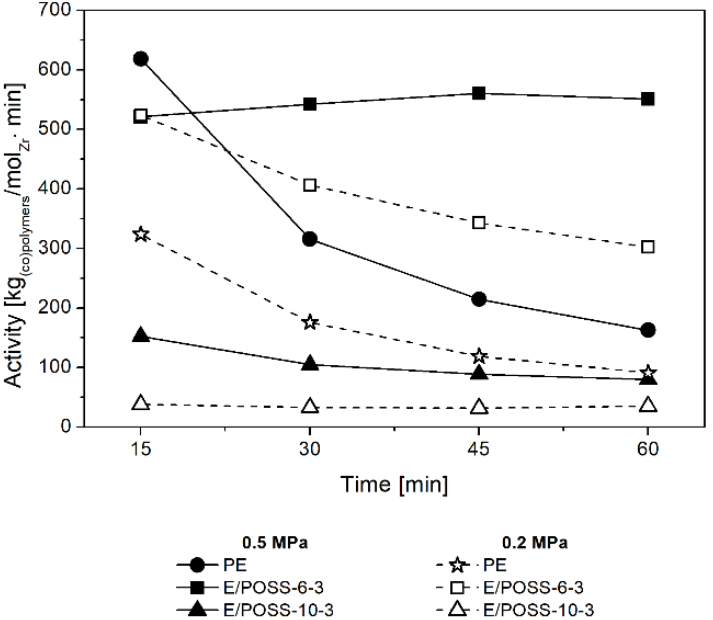
Figure 3. Effect of the reaction time on the activity of the rac -Et(Ind) 2 ZrCl 2 /MMAO catalytic system in (co)polymerization.